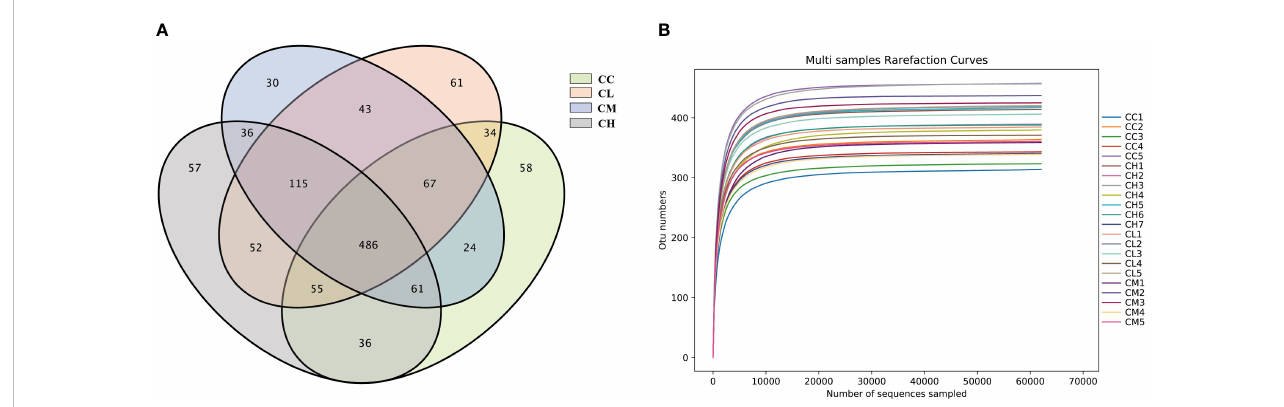
FIGURE 5 OTUs number and dilution curve of intestinal microbiota of mice. (A) OTUs number. (B) dilution curve. CC: control group, CL: low-dose GFPS group, CM: medium-dose GFPS group, CH: high-dose GFPS